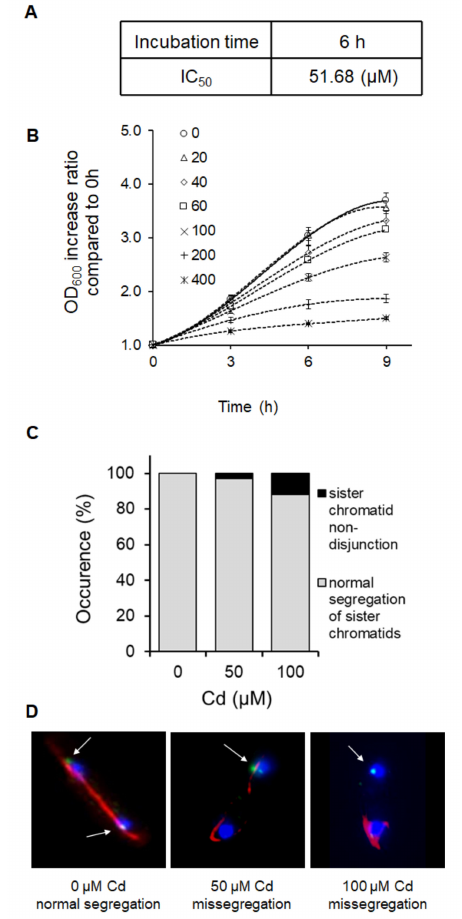
Figure 1. Cadmium a ff ects chromosome segregation and impairs cell growth. ( A ) The half maximal inhibitory concentration (IC 50 ) value represents the Cd concentration that reduces the growth of wild-type S. pombe cells to